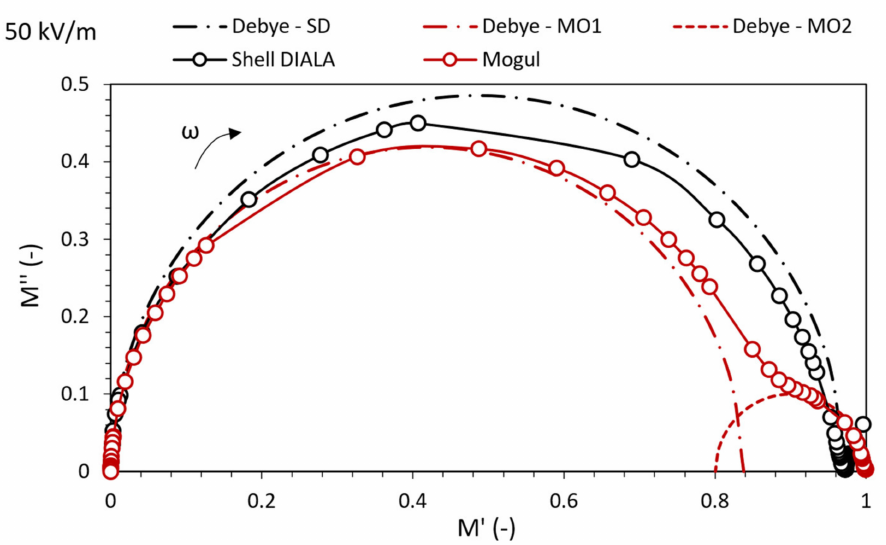
Figure 9. Comparison of electrical insulating oils of the intensity E of time-varying electric field 50